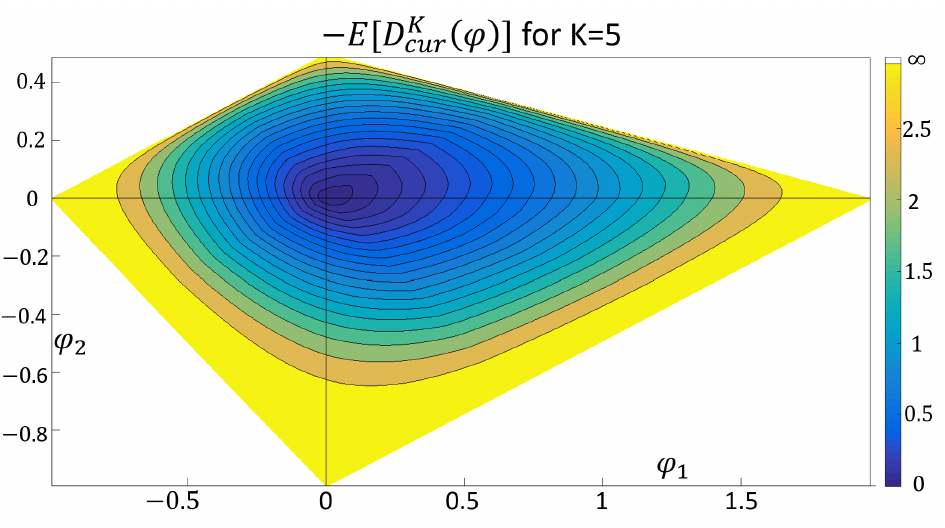
Figure 5. Contour levels for r ( K ) cur from (68) with K = 5 for Example